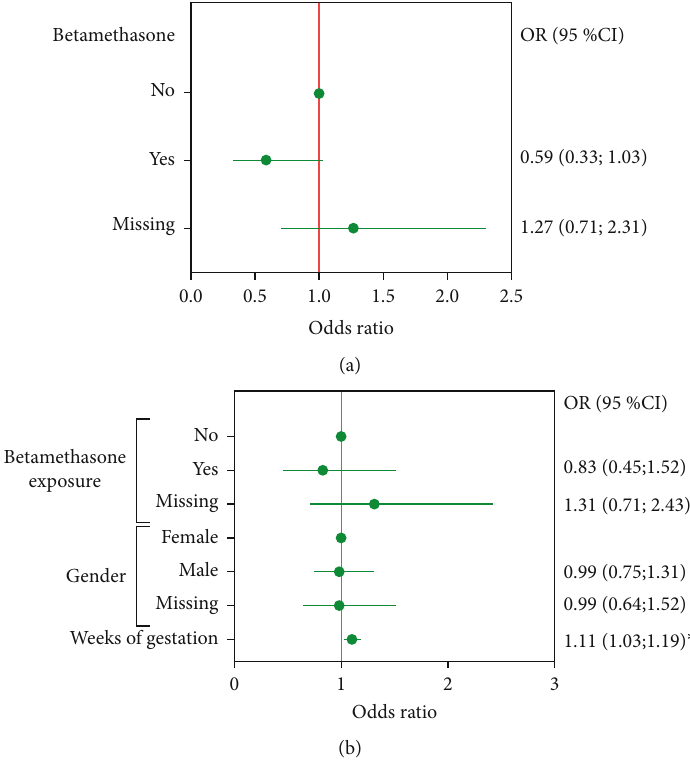
Figure 2: Prenatal betamethasone administration and type 1 diabetes risk. (a) Forest plot of the univariate logistic regression odds ratios (OR) and 95% con fi dence interval (95% CI) for the risk of type 1 diabetes (T1D) according to prenatal betamethasone exposure. (b) Forest plot of the multivariate logistic regression OR and 95% CI for the risk of T1D according to prenatal betamethasone exposure, gender, or week of gestation. T1D OR was adjusted for birth weight, gender, and weeks of gestation. ∗ p < 0 : 01 , multiple logistic